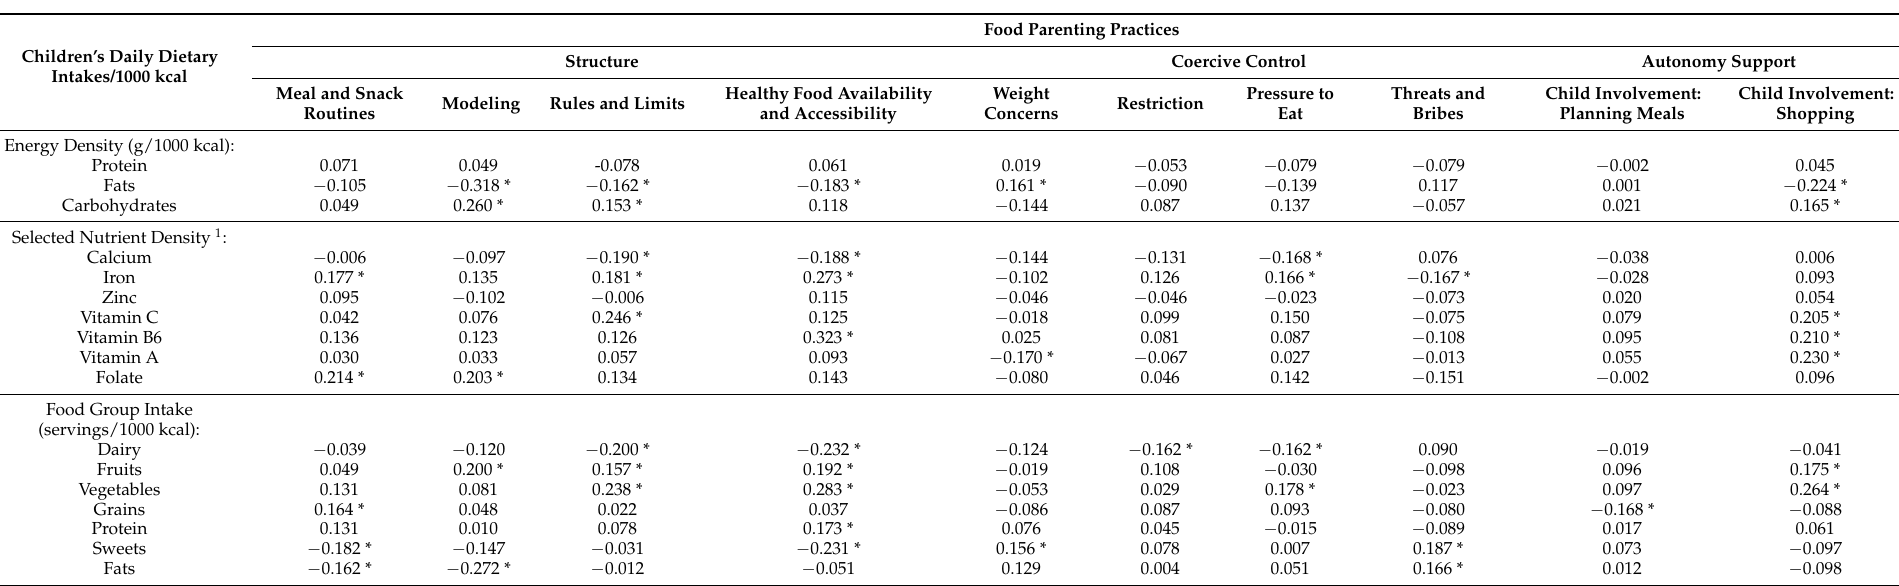
Table 3. Spearman’s correlation analysis between daily dietary intakes and food parenting practices subconstructs for